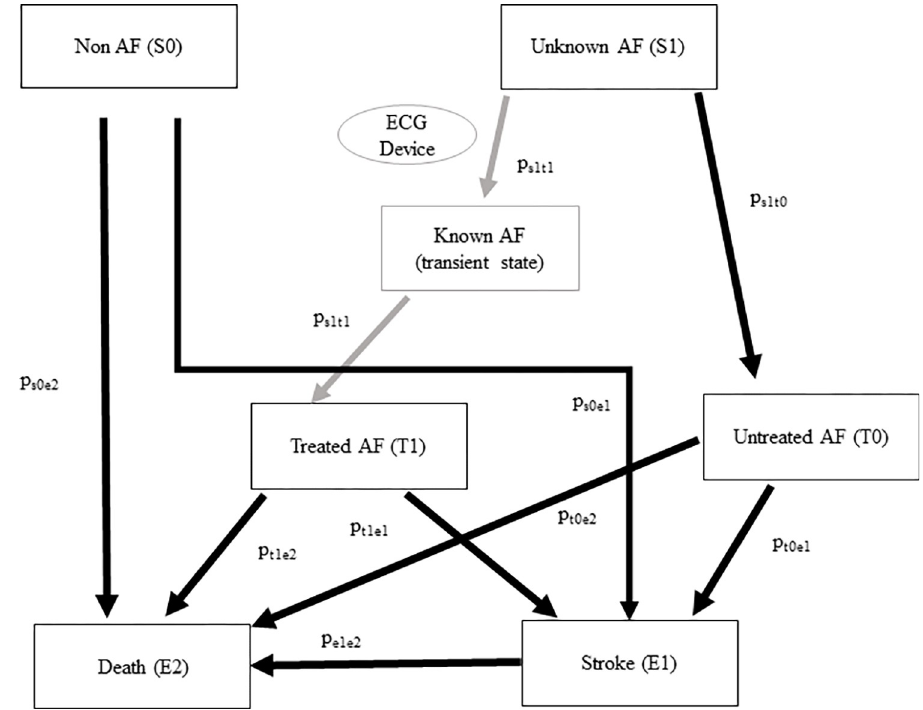
Fig 2. Markov model used in